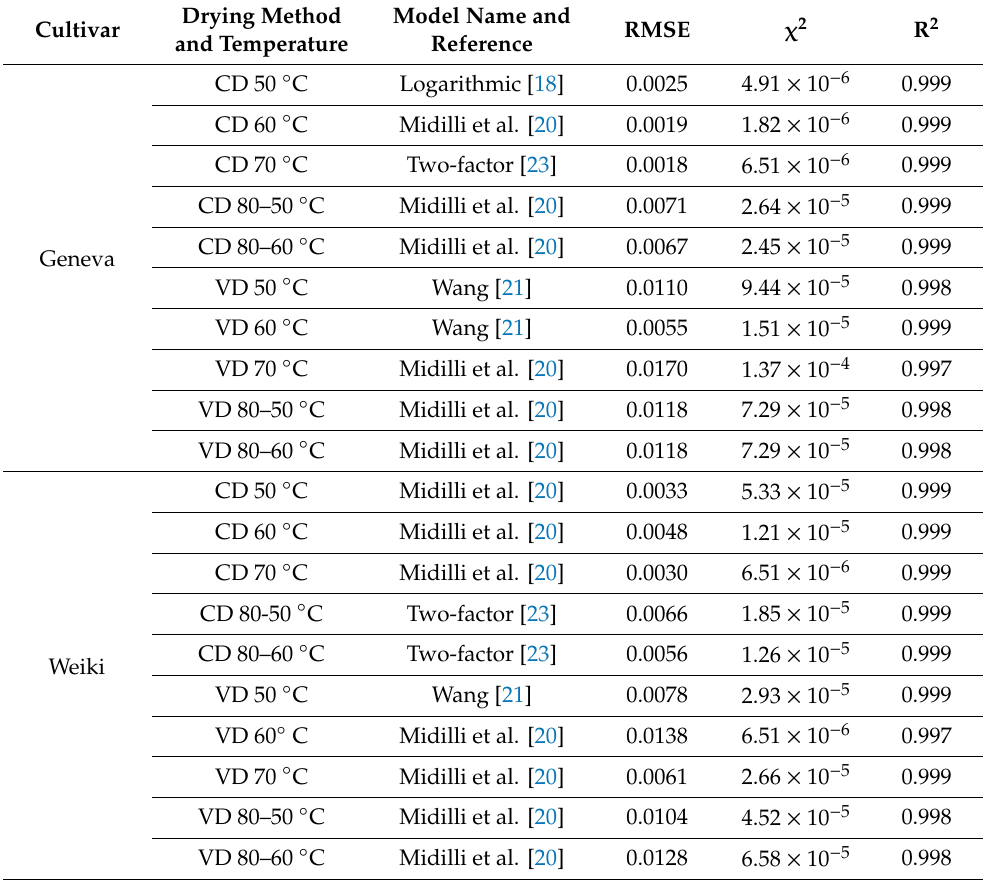
Table 3. Statistical analysis of evaluated best fitted mathematical models for tested methods of drying.